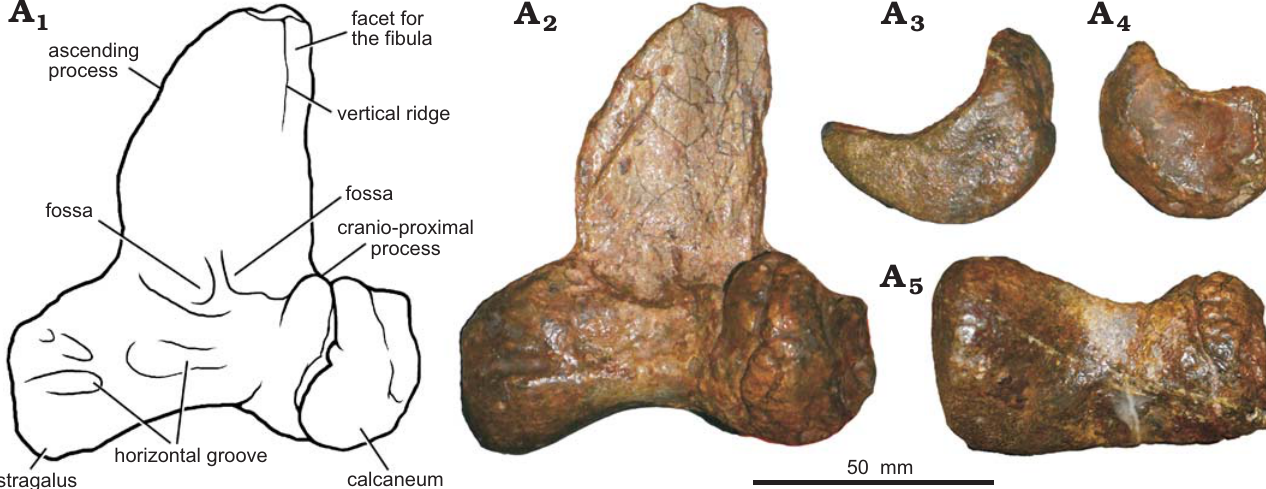
Fig. 17. Coelurosaurian theropod Vayuraptor nongbualamphuensis gen. et sp. nov. from the Early Cretaceous Sao Khua Formation of Phu Wat, Nong Bua Lamphu Province, Thailand. SM-NB A1-2, left astragalocalcaneum in anterior (A 2 ), medial (A 3 ), lateral (A 4 ), and distal (A 5 ) views; line drawing in anterior view (A 1